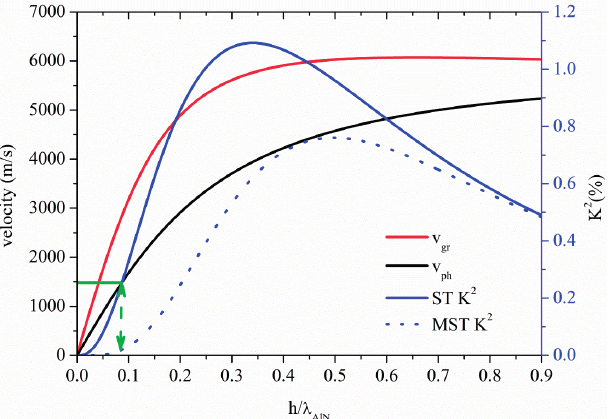
Figure 9. Phase velocity and K 2 dispersion curves of the A 0 mode propagating along the MST and ST configurations.